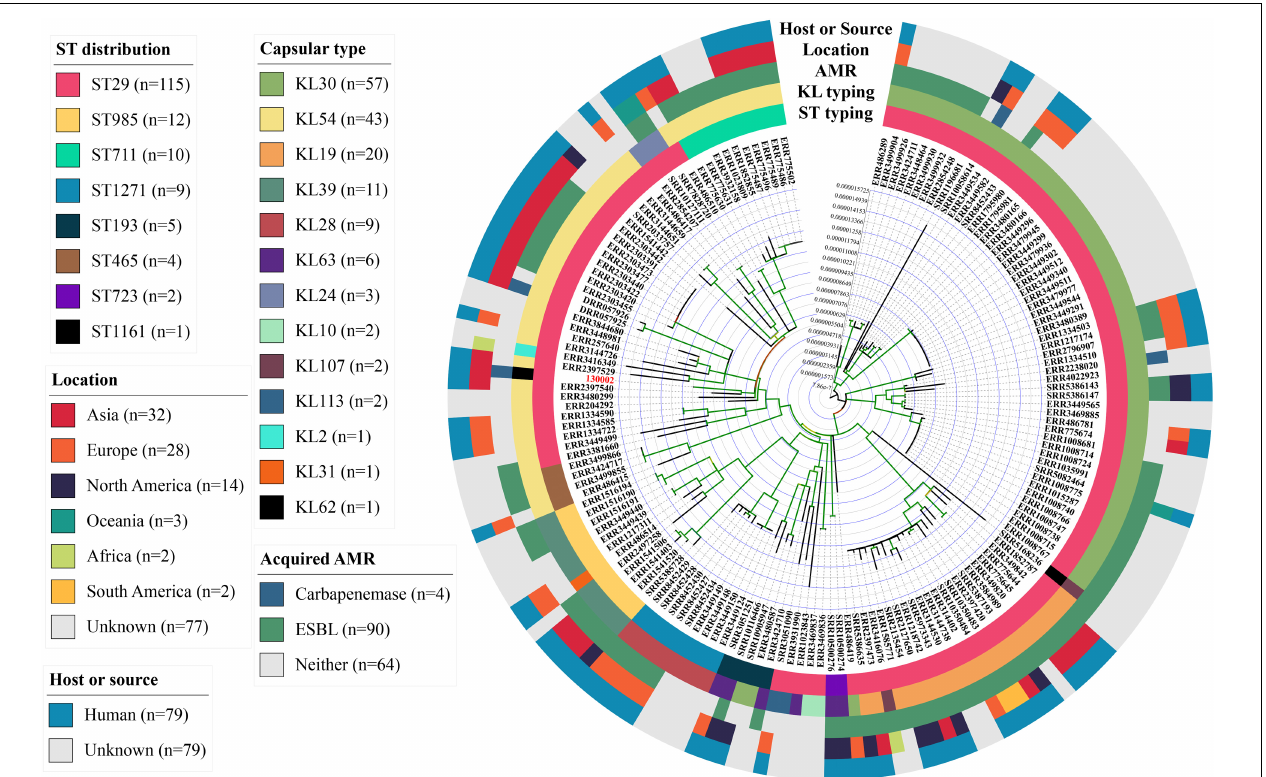
FIGURE 1 | Phylogenomic tree of K. pneumoniae strains of the ST29 complex. This phylogenomic tree of 130002 and 157 genomes of the ST29 complex is based on SNP calling using Snippy v4.6.0 and filtering recombination using Gubbins v2.4.1. The phylogeny was inferred using RAxML v8.2.12 under the GTRGAMMA model with a 1,000-bootstrap test and is annotated and viewed in iTOL v5.7 and FigTree v1.4.4. More information of the genomes is provided in Supplementary Datasheet 1 .